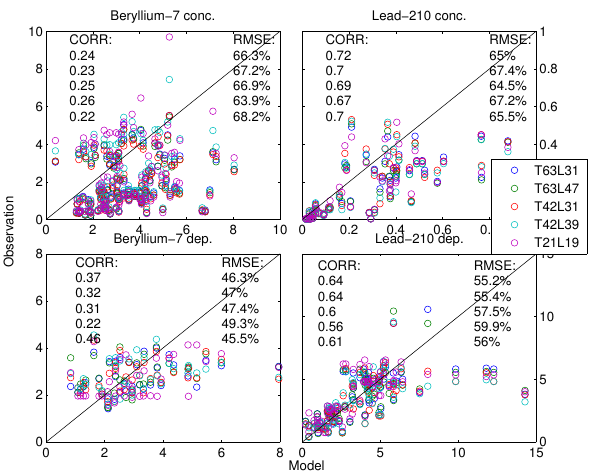
Fig. 7. Scatter plot of modelled versus observed 1998–2002 mean 7 Be and 210 Pb surface air concentrations (mBq m − 3 STP) and deposition flux of 7 Be atoms (100m − 2 s − 1 ) and 210 Pb atoms (1000m − 2 s − 1 ) with different model resolutions. Correlation coefficients and root mean squared errors are also shown for each resolution, in the order indicated in the legend.